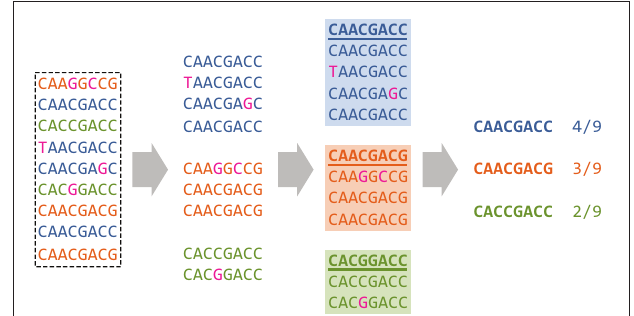
FIGURE 3 | Local read clustering. The local window of the MSA displayed in Figure 2 is considered (dashed-line rectangle), with colors defined as in Figure 2 . Reads that are more similar to each other than to other reads are grouped together which recovers the three original haplotypes A, B, and C of Figure 2 as indicated by the three different colors. Each cluster center sequence is a predicted haplotype (bold, underlined) and the size of its corresponding cluster is an estimate of the frequency of the haplotype (here, 4/f/9, and 2/9,